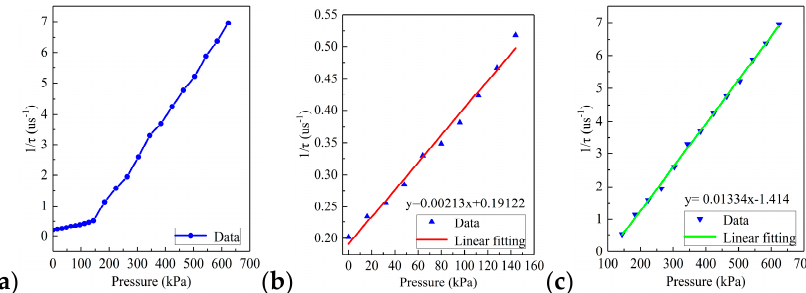
Figure 11. The relationship between the ring-down time and static ice pressure on the sidewall; ( a ) ring-down time-pressure curve of the overall range of sensor; ( b ) calibration curve of the low-pressure area; ( c ) calibration curve of the high-pressure area.